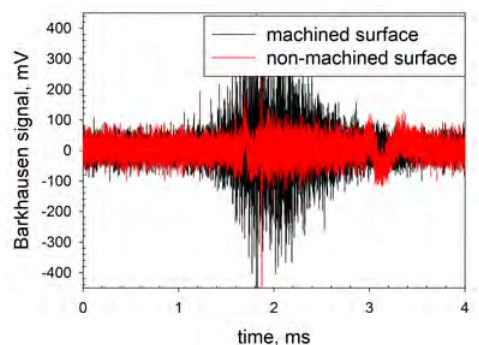
Figure 6. Barkhausen noise records of austenite steel of machined surface with and non-machined surface without strain-induced